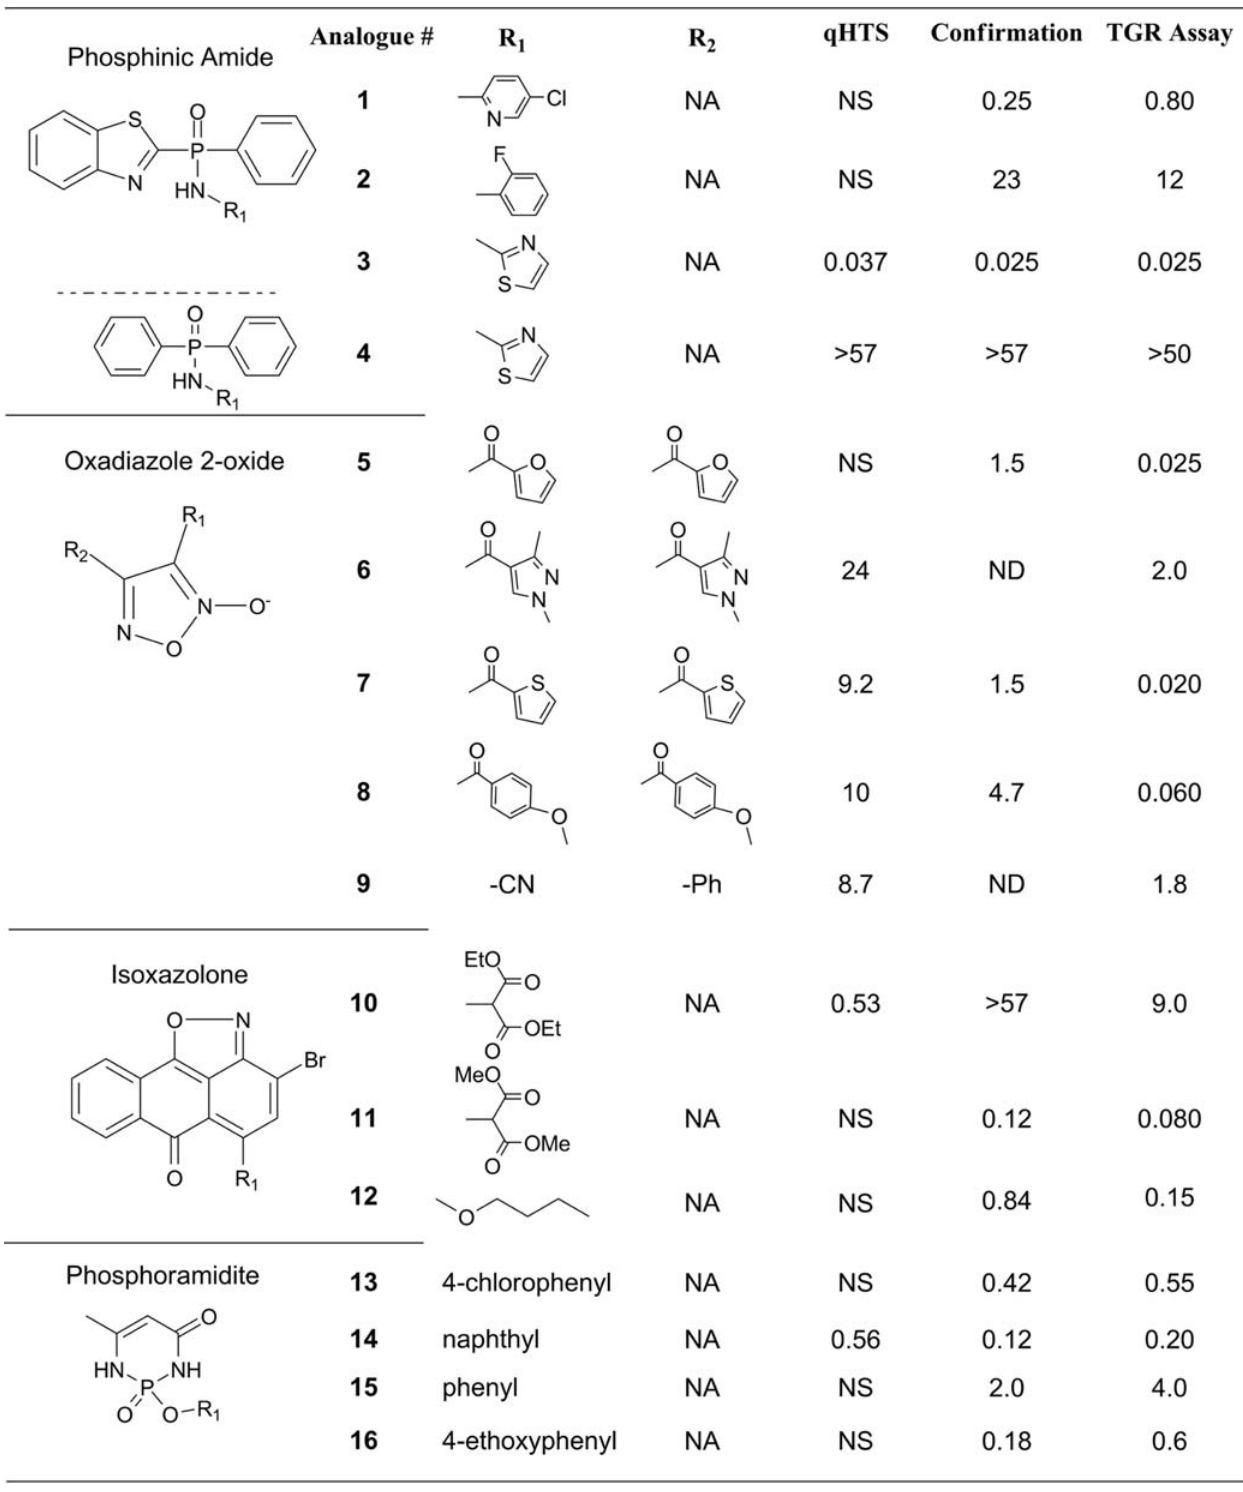
Figure 4. Structure and potency (IC 50 in m M) of actives and series expansion analogues. ‘qHTS’ lists the IC 50 values obtained from the initial high throughput screen of the collection; ‘confirmation’ represents the IC 50 values obtained using the identical assay as in the qHTS from the compounds identified in qHTS and expansion series; ‘TGR Assay’ is the IC 50 values obtained in an assay of TGR activity using DTNB as a substrate. NS, not screened (compound not in the screening collection), ND, not determined, NA, not applicable. IC 50 values greater than 50 or 57 m M signify lack of fitted curve through the dose-response data, i.e. flat response within the range tested.